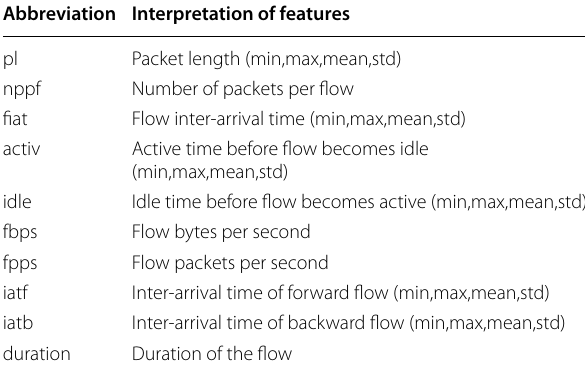
Table 2 Description of the flow features Abbreviation Interpretation of